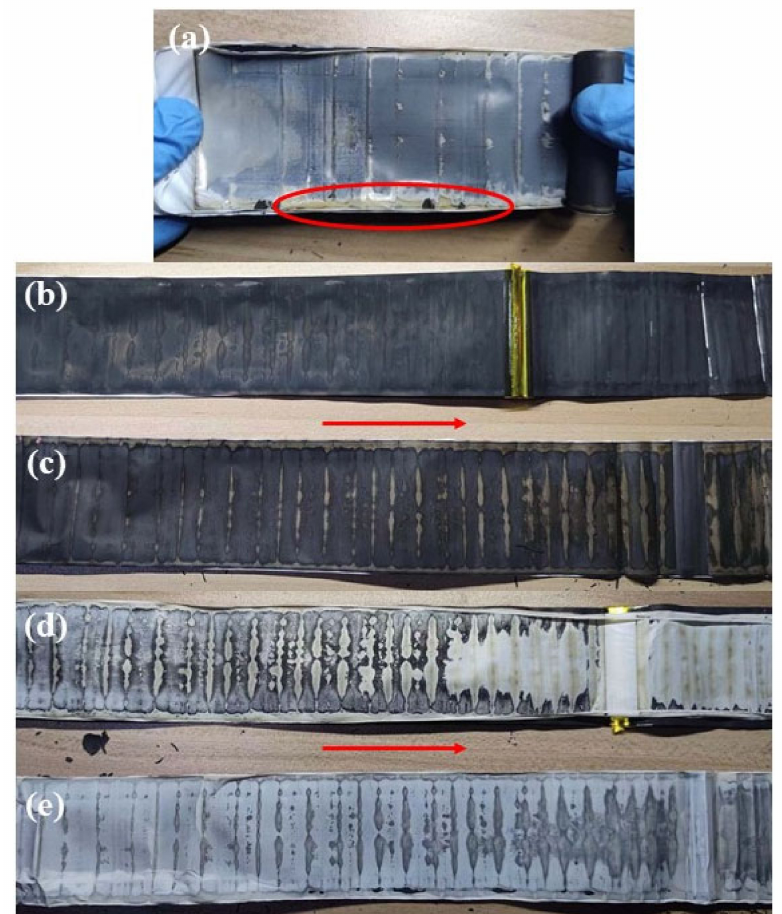
Figure 7. Disassemble image of a -type NCM811 battery after 130 cycles at the cycle ratio of 2 C with the cut-off voltage of 1 V. ( a ) Disassembled battery. ( b ) Positive electrode. ( c ) Negative electrode. ( d ) Separator facing the negative electrode. ( e ) Separator facing the positive